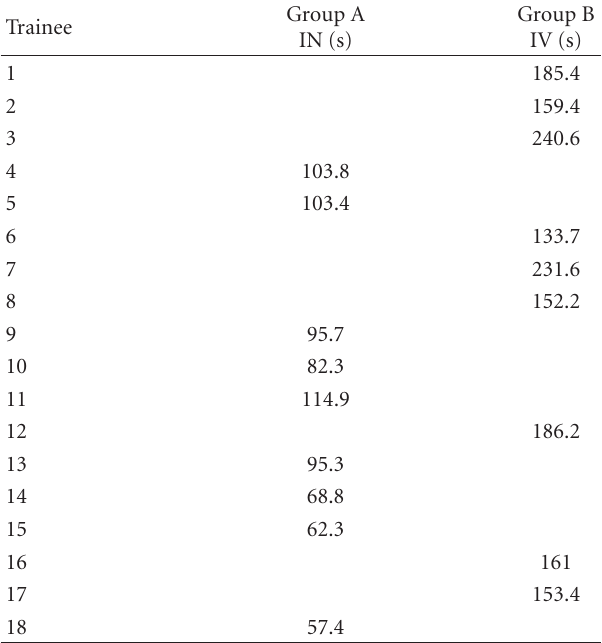
Table 1: Advanced paramedic trainees shown by time taken for medication